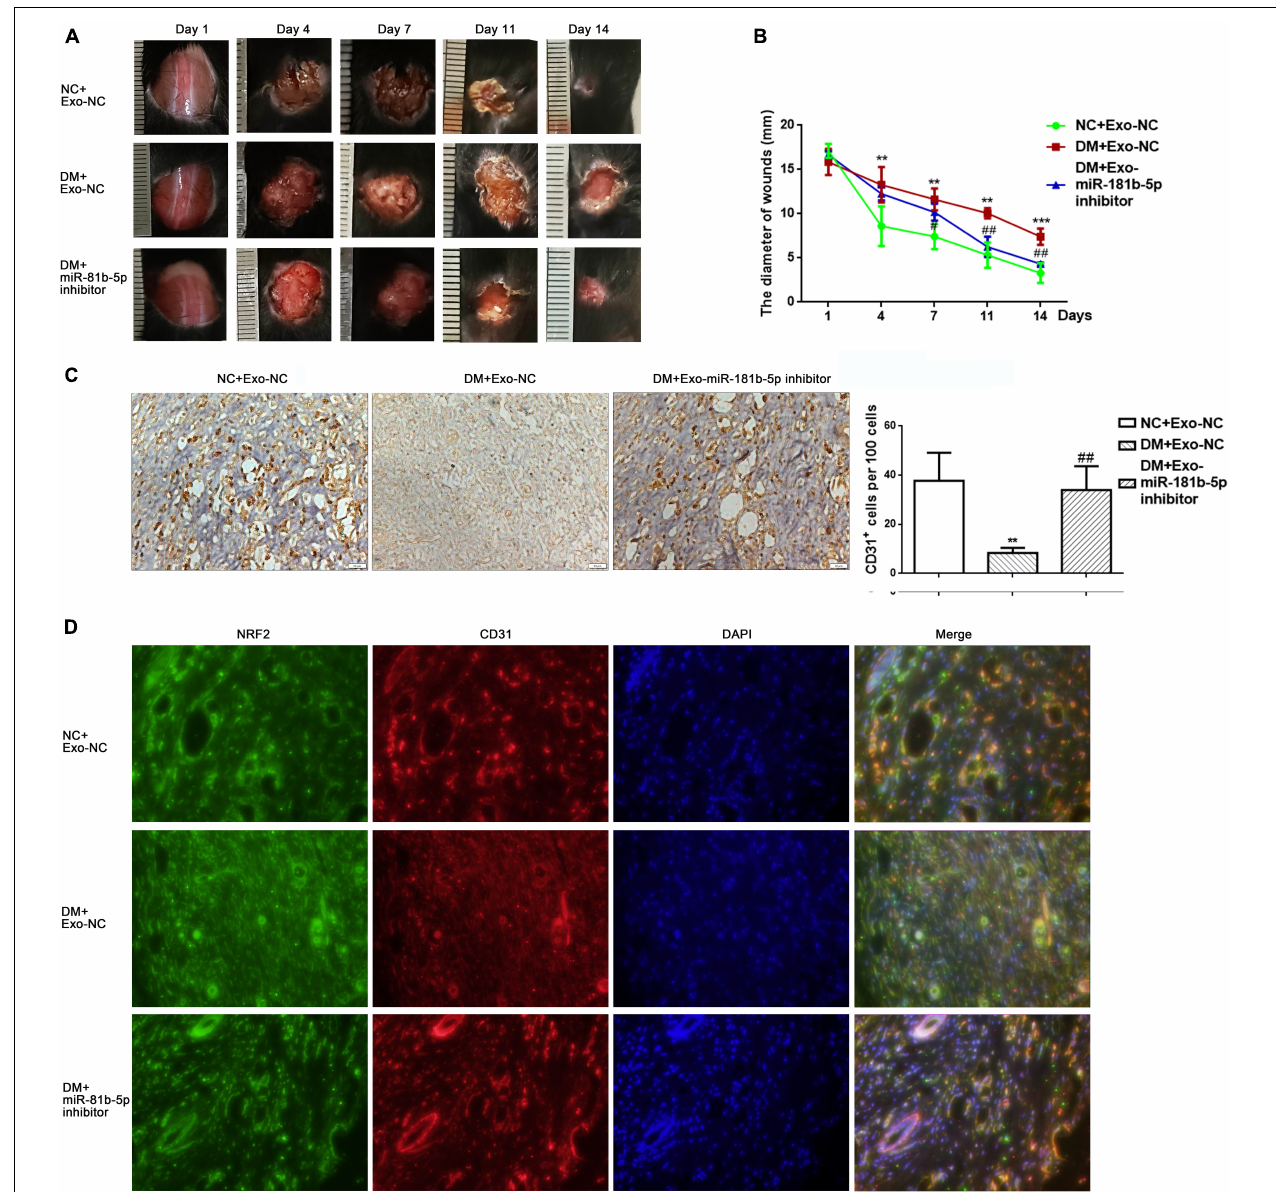
FIGURE 5 | Knockdown of miR-181b-5p in exosomes restored wound healing. (A,B) Wound closure rate of full-thickness dermal defects on days 1, 4, 7, 11, and 14 after skin operation. ** P < 0.01, *** P < 0.001 vs. NC + Exo-NC, # P < 0.05, ## P < 0.01 vs. DM + Exo-NC. (C) CD31 immunohistochemical stain showing the vascular density in three groups. ** P < 0.01 vs. NC + Exo-NC, ## P < 0.01 vs. DM + Exo-NC. (D) Immunofluorescence stain showing the expression of NRF2 in a CD31-positive area.